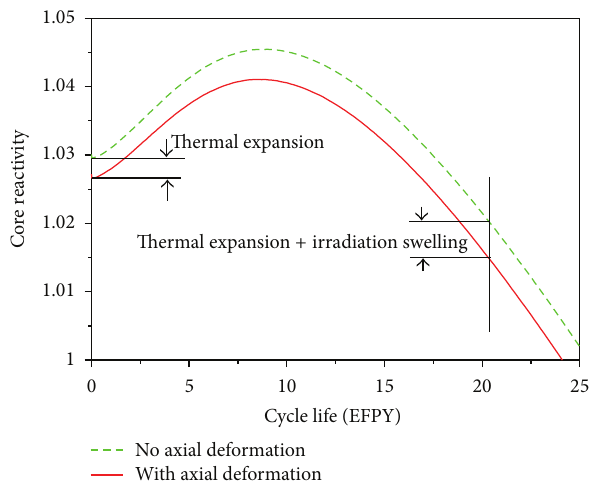
Figure 16: Influence of axial expansion on cycle lifetime.